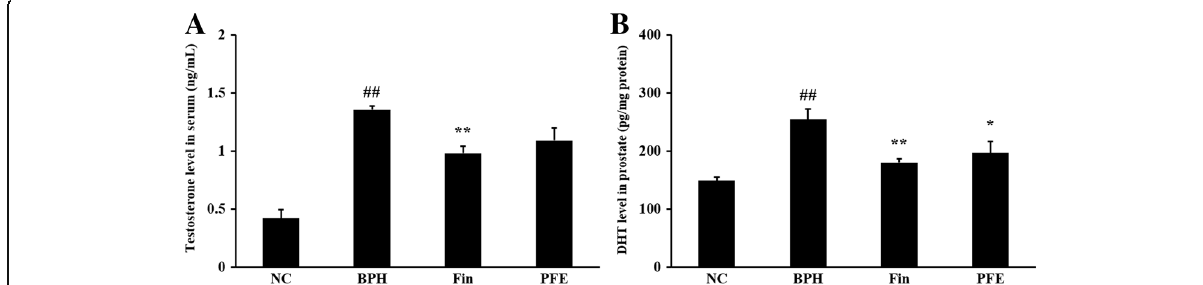
Fig. 4 Effect of PFE on the levels of testosterone ( a ) and DHT ( b ) in serum and prostatic tissue. Individual data were obtained using an ELISA. NC (normal control group), corn oil injection (s.c.) + PBS administration (p.o.); BPH (control group), TP (3 mg/kg)/corn oil injection (s.c.) + PBS administration (p.o.); Fin (positive control group), TP (3 mg/kg)/corn oil injection (s.c.) + finasteride administration (10 mg/kg, p.o.); PFE (PFE-treated group), TP (3 mg/kg)/ corn oil injection (s.c.) + PFE administration (200 mg/kg, p.o.). Data are presented as mean ± S.E.M. ( n = 6). Significant differences at ## P < 0.01 compared with the NC group. Significant differences at * P < 0.05 and ** P < 0.01 compared with the BPH group. BPH, benign prostatic hyperplasia; DHT,